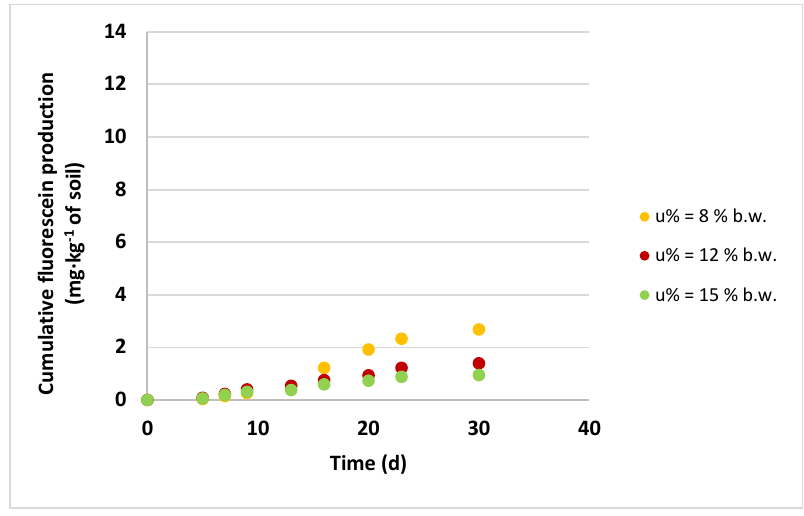
Figure 1. Cumulative fluorescein production by microcosms with C/N = 60.